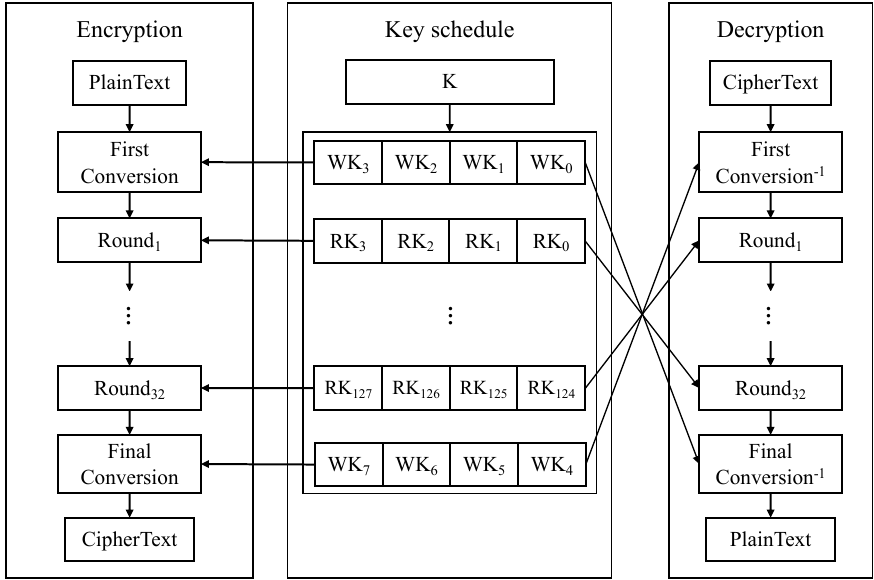
Figure 1. Key schedule and round function of